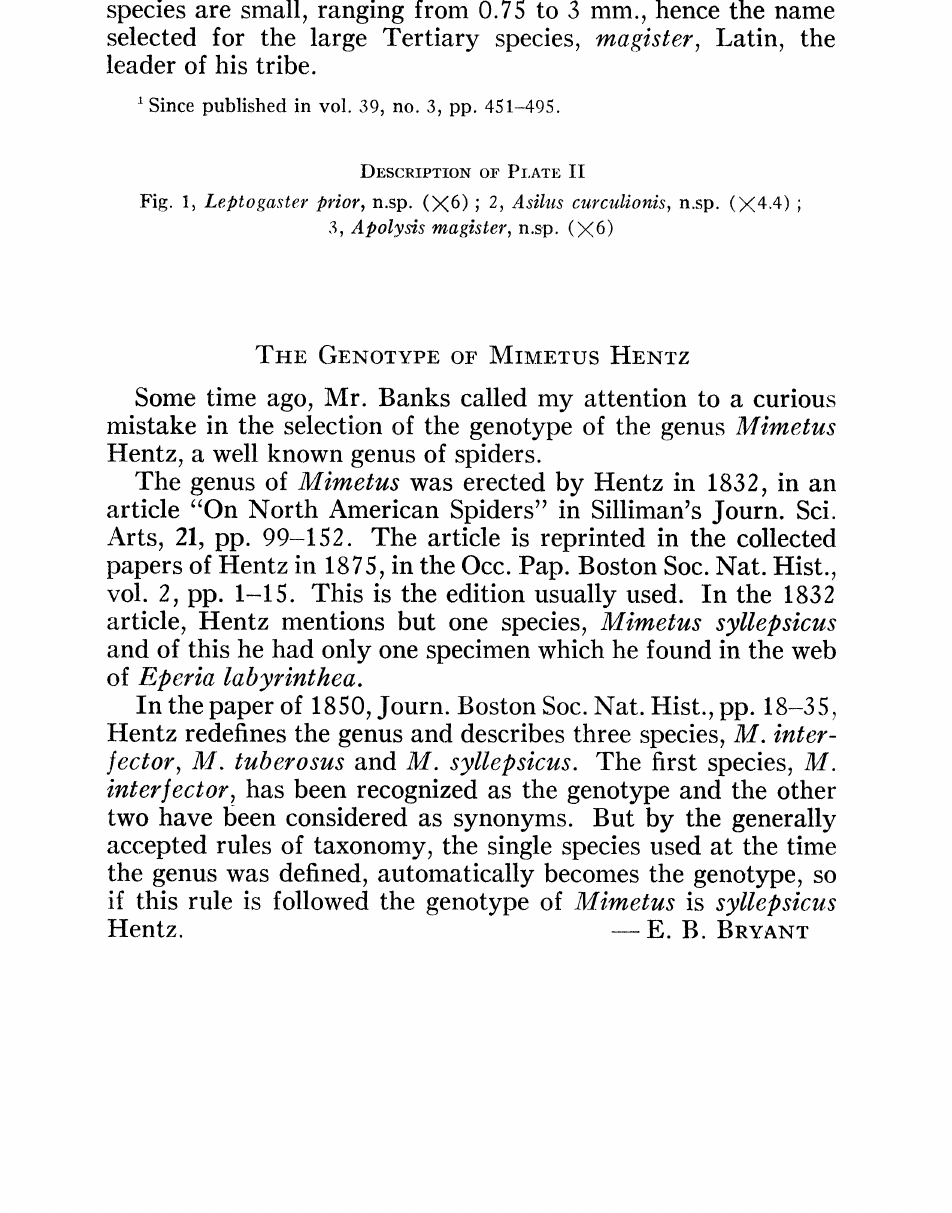
Fig. 1, Leptogaster prior, n.sp. (X6) 2, Asilus curculionis, n.sp. (X4.4) 3, Apolysis magister, n.s,p.